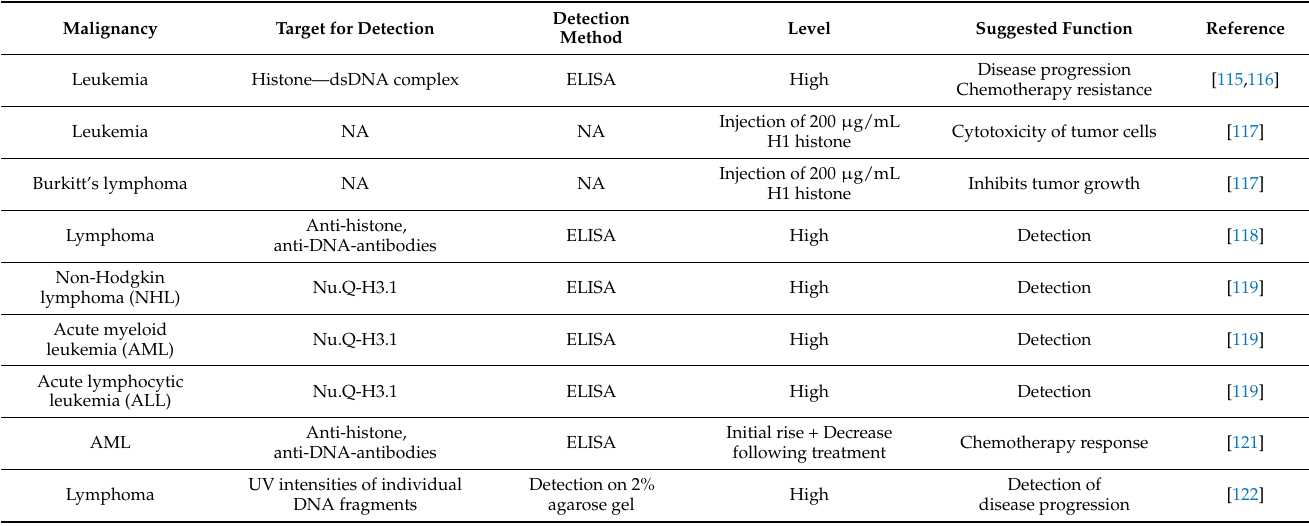
Table 3. Circulating histones and histones complexes in hematologic